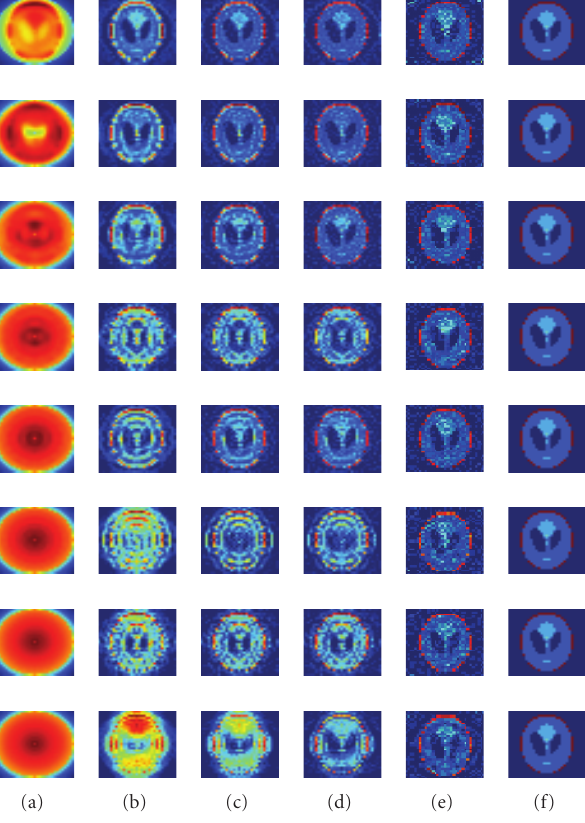
Figure 6: Comparison of reconstructed images in two-dimensional simulation after (a) 1, (b) 9, (c) 17, and (d) 25 iterations. (e) The image reconstructed as A − 1 B T p . (f) The original phantom.